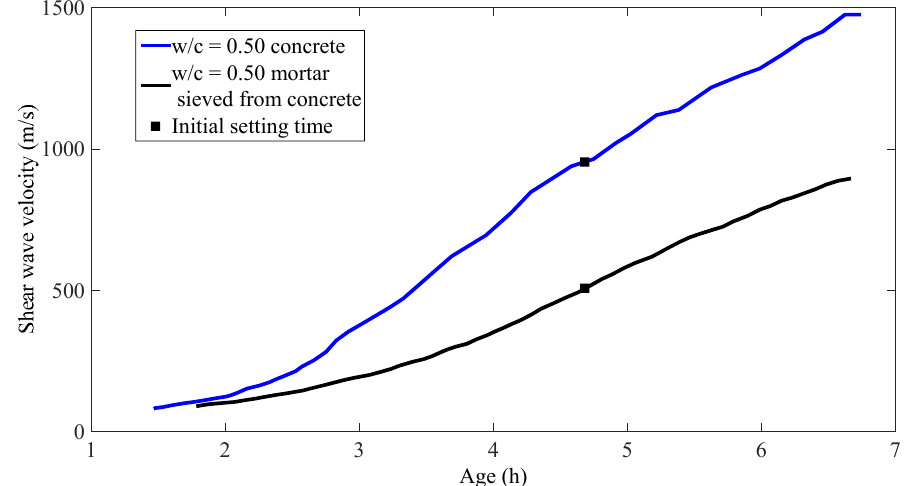
Figure 10. Shear wave velocities in concrete and mortar sieved from concrete.